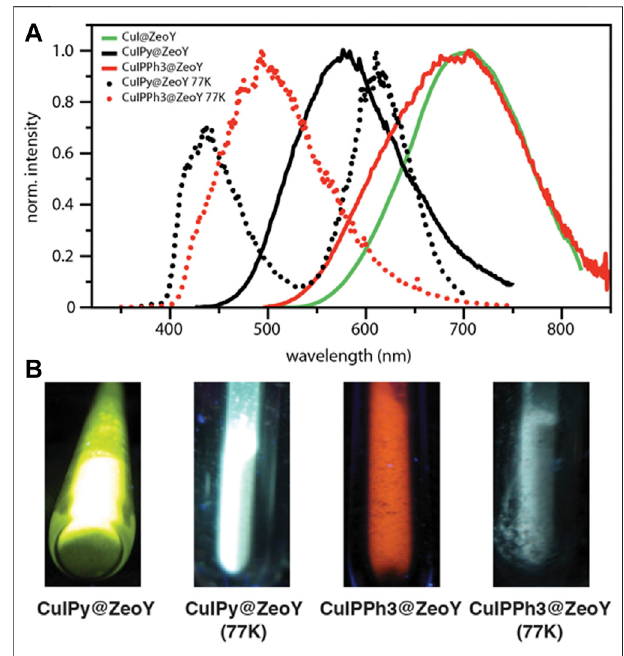
FIGURE 4 | Emission spectra of CuI@ZeoY in solid-state condition; λ exc = 414